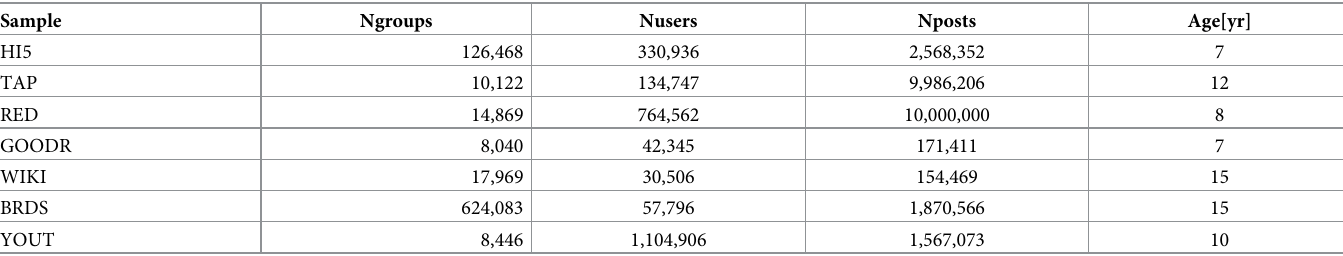
Table 3. Summary statistics of the datasets that were